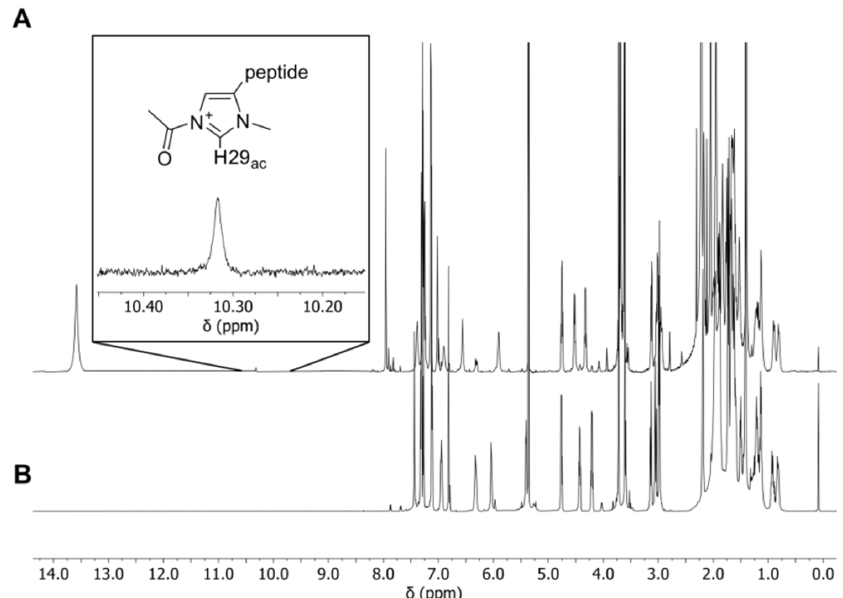
Figure 5. Full 1 H − NMR-spectra of tetrapeptide 1 without ( B ) and with ( A ) acetic anhydride 3 in DCM − d 2 at − 20 °C (700 MHz 1 H frequency). Insert highlighting a new signal appearing after addition of acetic anhydride (ratio 3 : 1 = 7.11).